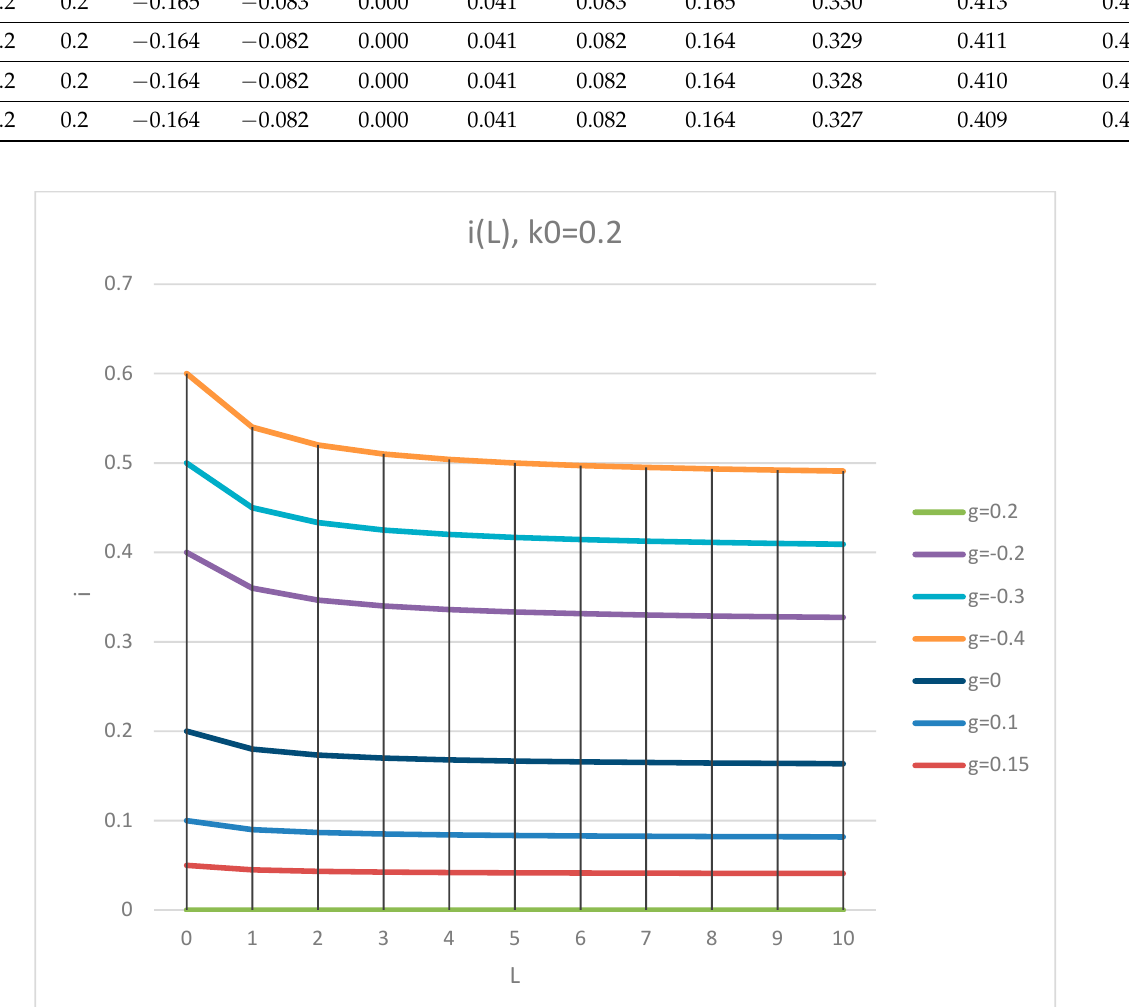
Figure 4. Dependence of discount rate i on leverage level L in Generalized Modigliani–Miller theory (GMM theory) at k 0 = 0.2 and g = 0; 0.1; 0.15; ± 0.2; − 0.3; − 0.4.